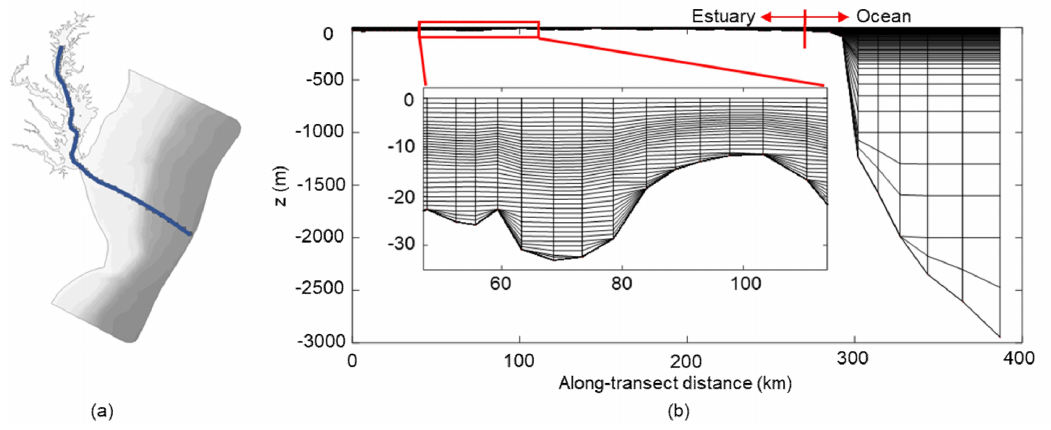
Figure 5. Illustration of the vertical grid: ( a ) a transect from the Bay head to the ocean; ( b ) the vertical grid on the transect shown in ( a ), with a zoomed-in view on the estuarine